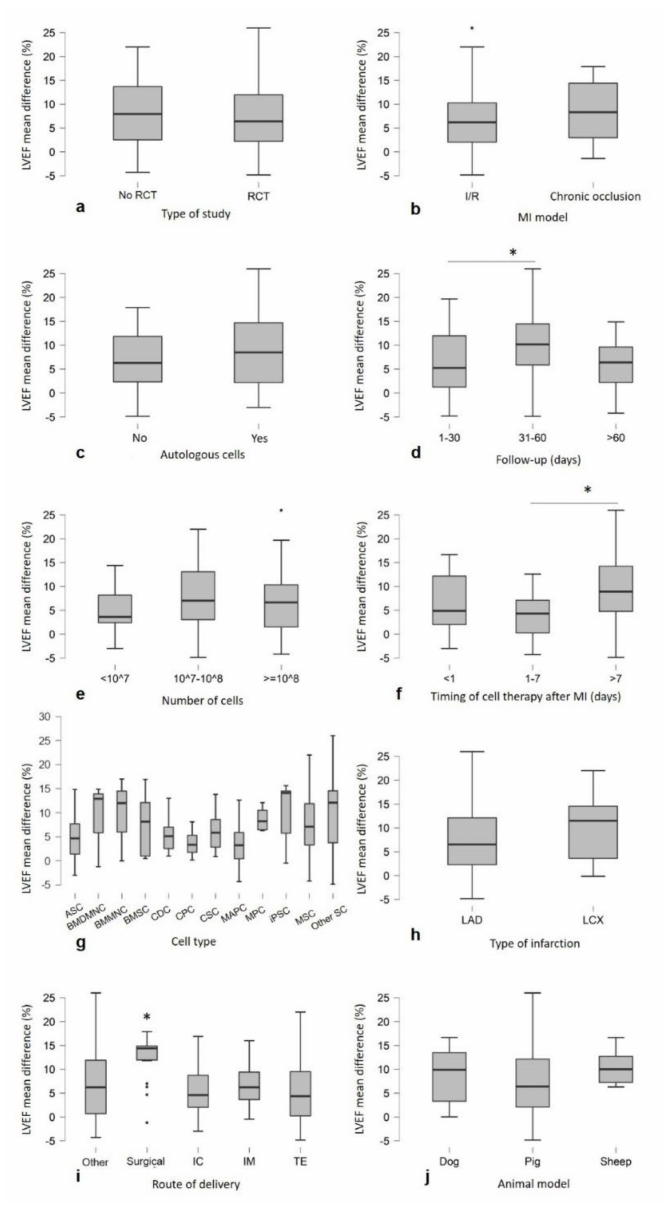
Figure 3. Subgroup analysis showing the LVEF trends toward more improvements after cell therapy compared with control: ( d ) follow-up at 31–60 days ( p = 0.025), ( f ) the late cell injection (>7 days, p = 0.005), ( i ) surgical administration ( p < 0.001), ( b ) chronic occlusion model ( p = 0.063) and ( c ) autologous cells ( p = 0.079). No significant differences were observed in ( j ) animal model ( p = 0.355), ( h ) type of infarction ( p = 0.257), ( a ) type of study ( p = 0.345), ( e ) number of cells ( p = 0.39) and ( g ) cell type (n ≥ 3 studies) ( p = 0.361). Graphs are represented as Boxplots; the two segments that delimit the rectangle represent the 25th and 75th percentiles; the central segment is the median; the bars represent the minimum and maximum values, respectively; and the external points are the outliers. Note: (* p <0.05) represents statistical significance resulting from one-way ANOVA, followed by post hoc Tukey comparison